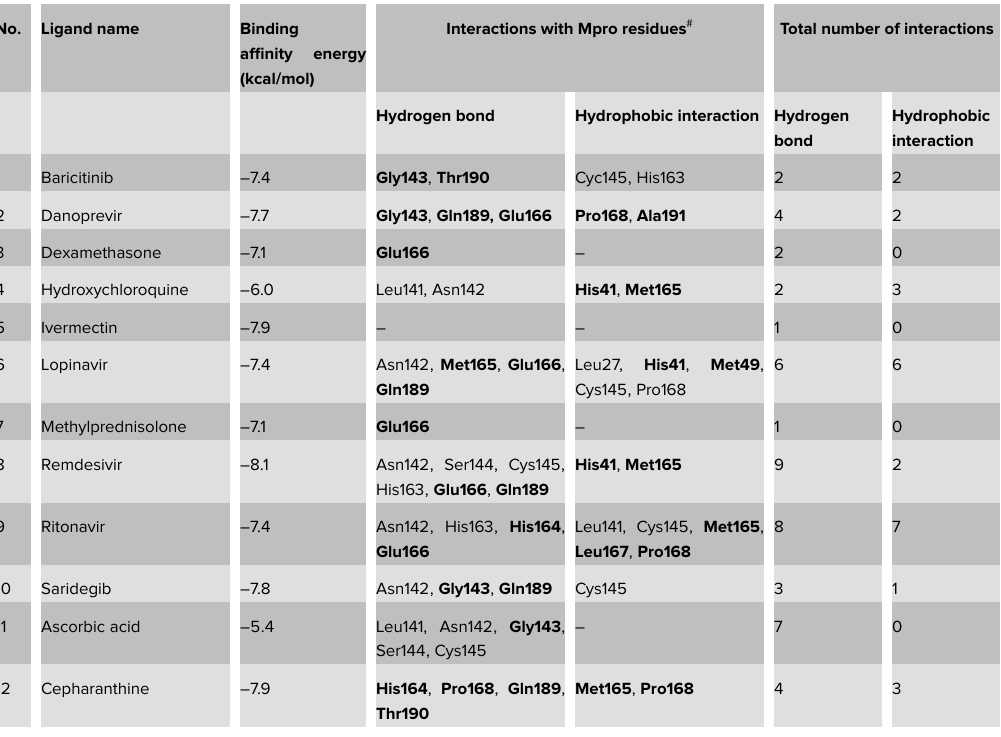
Table 3: The binding affinity energy of ligands and their interactions targeting SARS-CoV-2 main protease